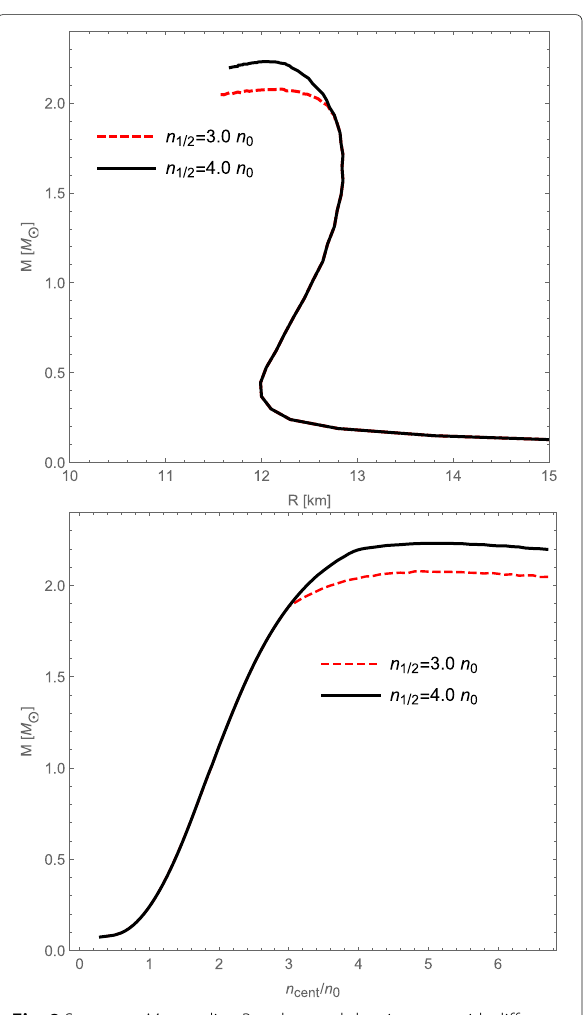
Fig. 8 Star mass M vs. radius R and central density n cent with different choices of n 1 / 2 . Note that below M ≈ 2 M (cid:3) , the curves for n 1 / 2 / n 0 = 3.0 and 4.0 represented in dashed line and solid line, respectively are